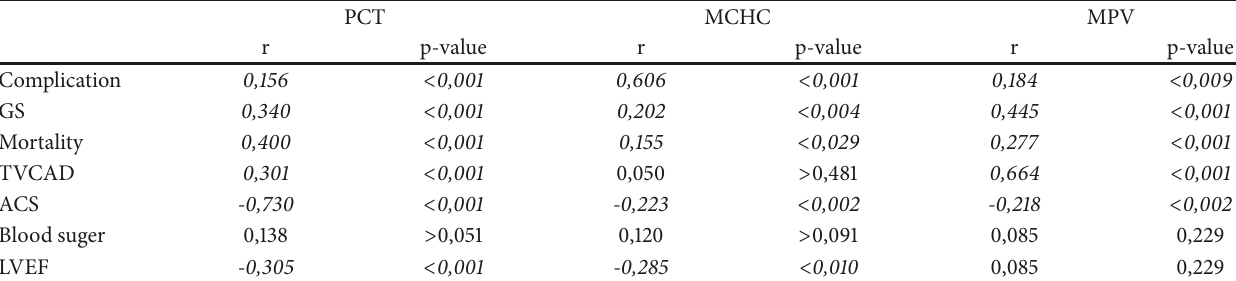
Table 4: Spearman correlation coefficients for PCT, MCHC, and MPV.